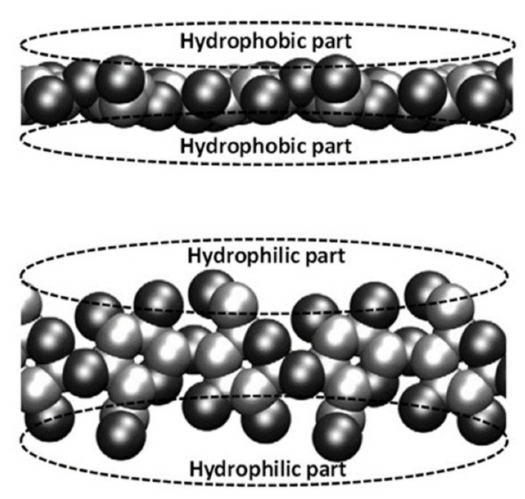
Figure 3. A Van der Waals surface representation of cellulose chain showing hydrophobic and hydrophilic parts. Oxygen atoms are colored black and non-polar carbon atoms are shaded grey in this representation. Reprinted from [33] © 2021 with permission from